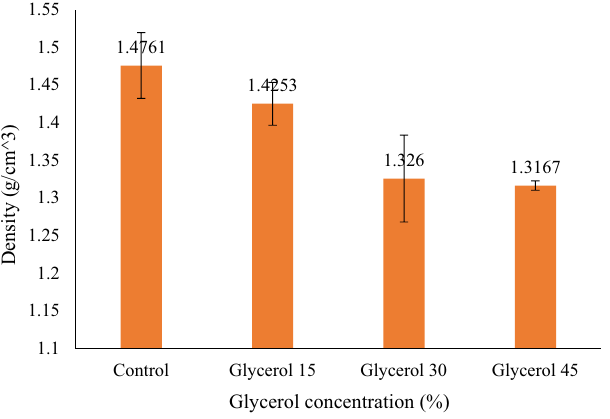
Figure 6. The density of AS films with different glycerol